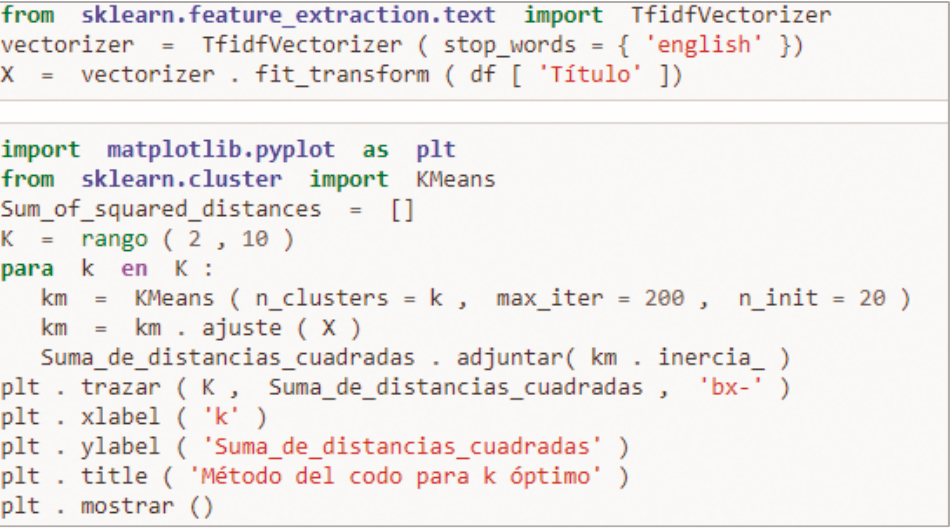
Figure 8. Code 5: TF-IDF Vectorization, own elaboration.